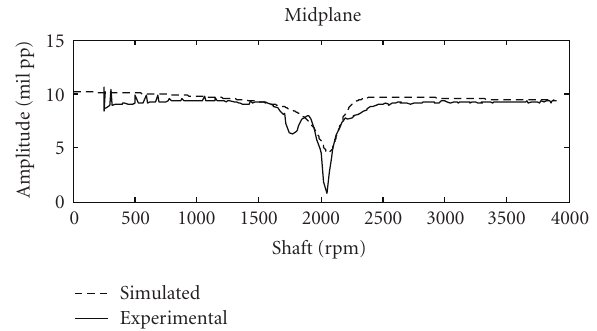
Figure 13: Bowed rotor experimental (exp.) and simulated (sim.) response.